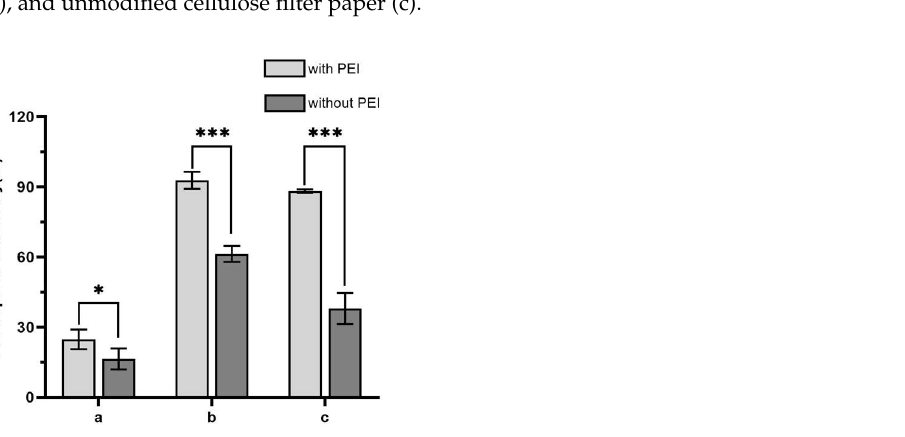
Figure 2. Fourier infrared spectra of the prepared paper@epoxy@PEI-DFFPBA (a), paper@epoxy@PEI (b), and unmodified cellulose filter paper (c).